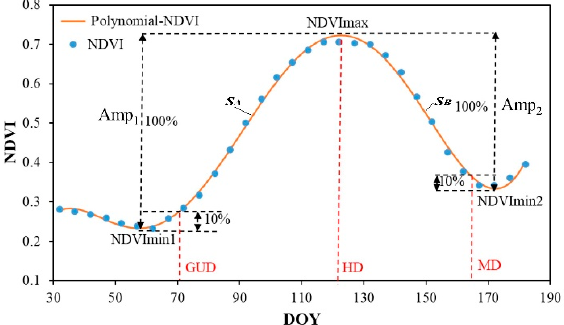
Figure 5. The definition of the average green-up date (GUD), heading date (HD), and maturity date (MD). DOY: Day of year. The average winter-wheat phenological curve is divided into two parts according to the maximum value of the curve, namely, S A and S B . The GUD was defined as the day when the NDVI first reached 10% of Amp 1 , and was obtained by subtracting NVDI min1 from NDVI max . The HD was defined as the day when the NDVI reached the maximum. The MD was defined as the day after the HD when the NDVI dropped to 10% of Amp 2 , and was obtained by subtracting NVDI min2 from NDVI max . Where NDVI max represents the maximum NDVI of the average winter-wheat phenological curve, NDVI min1 and NDVI min2 represent the minimum NDVI of S A and S B , respectively. Amp1 and Amp2 represent the amplitude of S A and S B , respectively.